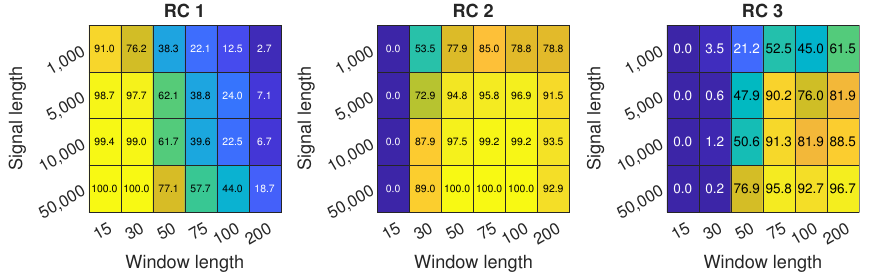
Figure 9. Inlet recirculation detection for RCs 1 to 3 with different signal length N and different window length L